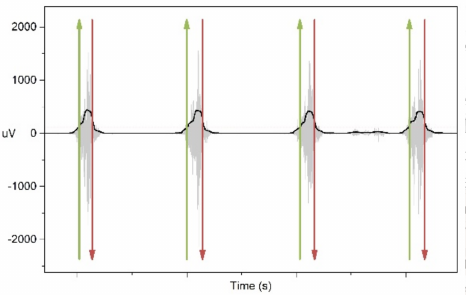
Figure 1. Muscle activation pattern of rectus femoris. The onset and offset of the muscle are designated by the arrows pointing upwards for the onset and downward for the